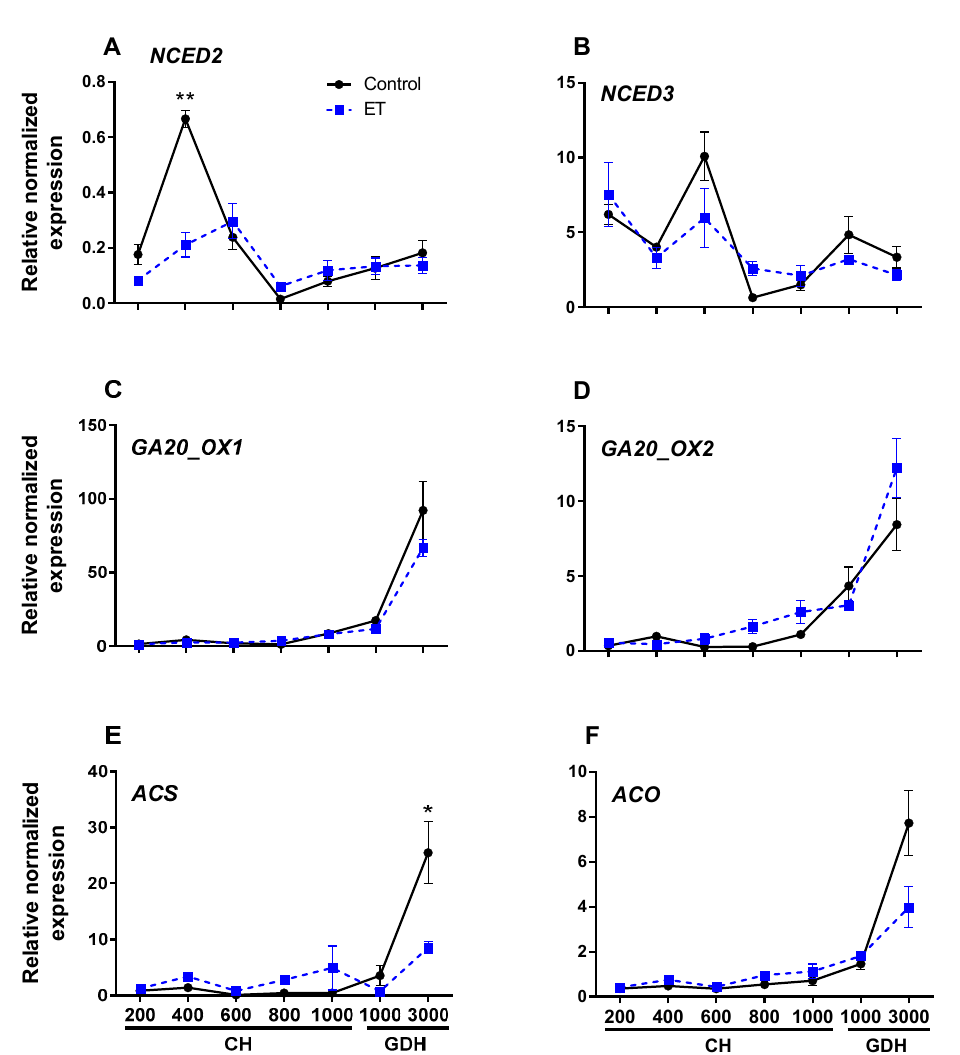
Figure 8. Relative normalized expression of genes that regulate biosynthesis of ABA ( A , B ), GA ( C , D ), and ethylene ( E , F ) in the floral buds of peach ‘Redhaven’. Expression of each gene was normalized to that of β - Actin and expressed relative to the control sample (20 CH). Each point represents the mean ± SE of three biological replicates, each with three technical replicates. Values marked with asterisks * and ** are significantly different at p < 0.05 and 0.01, respectively. NCED, 9-cis-epoxycarotenoid dioxygenase; GA20-OX, GA 20-oxidase; ACS, 1-aminocyclopropane-1-carboxylic acid (ACC)-synthase; and ACO, ACC-oxidase. CH, chilling hour; GDH, growing degree hour. Refer to Figure 7 legend for the sampling dates that correspond to the CH and GDH accumulation.